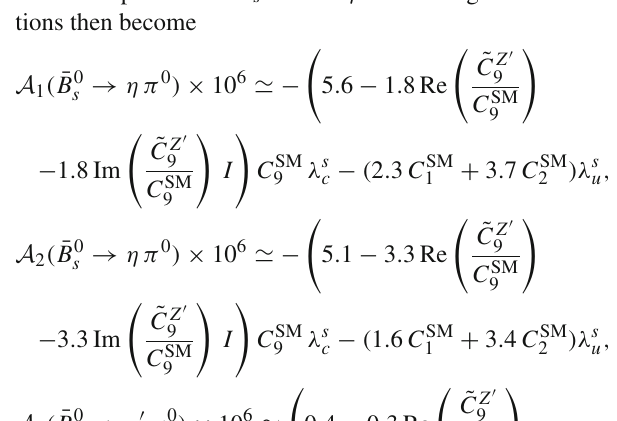
corresponding to the case Im ((cid:5) bs s